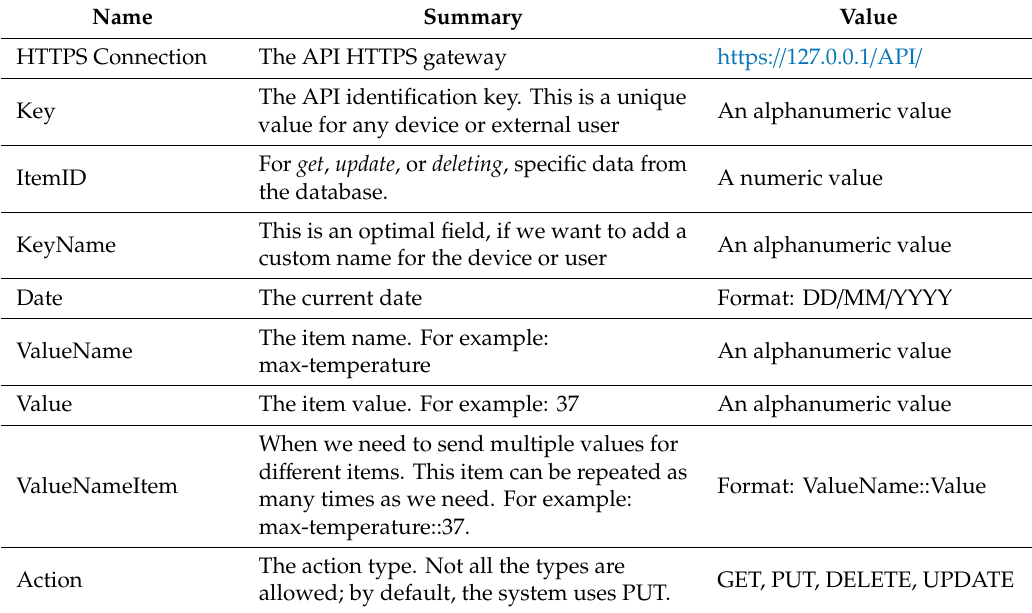
Table 2. Description of the